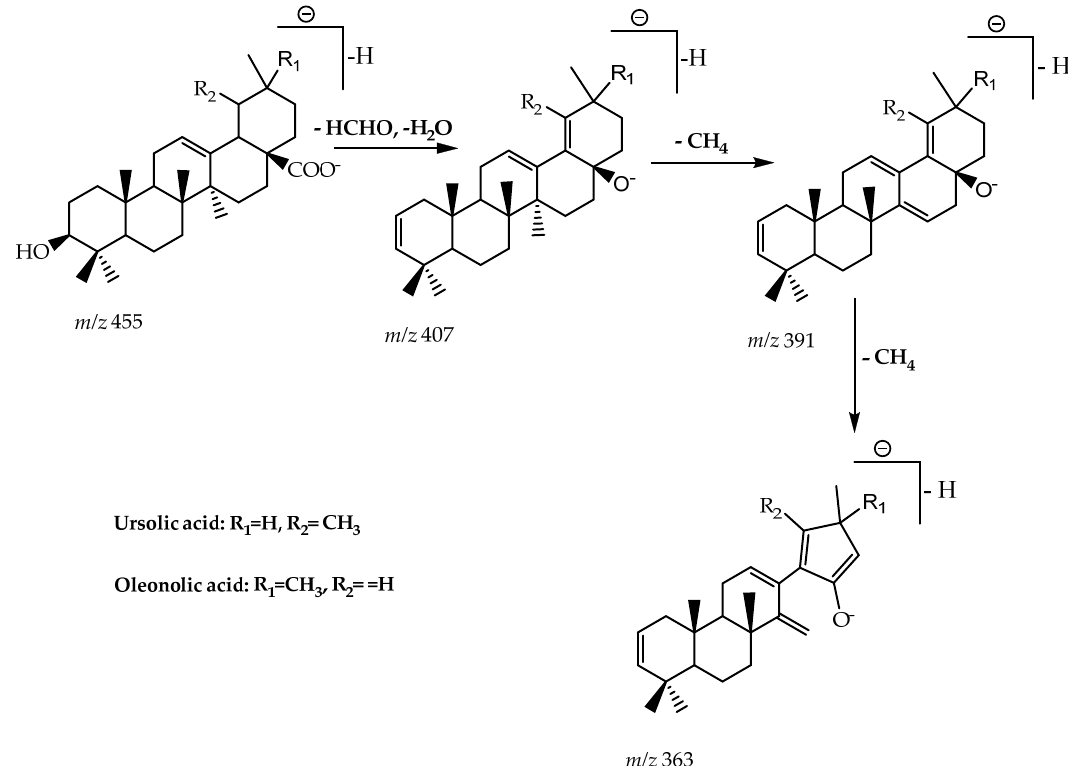
Figure 1. The proposed fragmentation pathways of Oleonolic acid and Ursolic